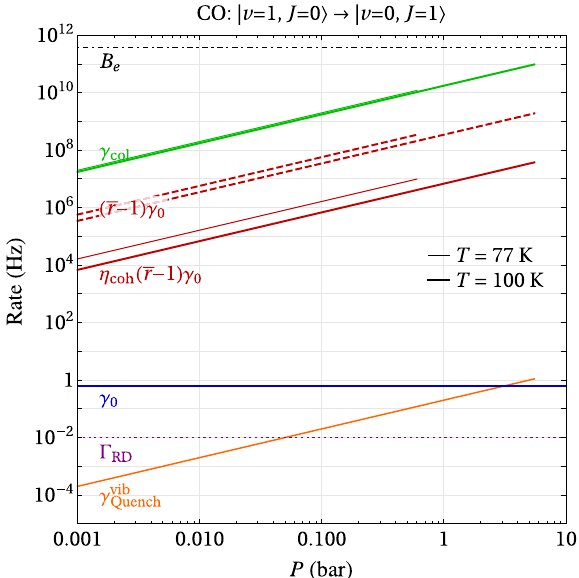
FIG. 7. Rate of absorption Γ (solid green line) and rate of abs FIG. 6. Dynamic rates of the two-level subsystem (solid red line) as a function of focused, coherent emission Γ S rad j v ¼ 0 ; J ¼ 1 i ↔ j v ¼ 1 ; J ¼ 0 i in carbon monoxide (CO), as DM energy ω ≃ m , in the phase I version of the stack configu- a function of pressure P . We plot the collisional broadening rate ration, filled with carbon monoxide (the 12 C 16 O isotopologue) at a γ (green line), the coherent emission rate in the absence or col pressure of 5 bar, temperature of 100 K, and “ stack enhancement presence of decoherence — ð ¯ r − 1 Þ γ 0 as the dashed red lines and ¯ ∼ 10 [cf. Eq. (7)]. The case study shown S=mR parameter ” ¯ r − 1 Þ γ η — for two temperatures T ¼ 100 K z 0 as solid red coh ð assumes a kinetically mixed photon with ϵ ¼ 10 − 12 , zoomed in (thick line) and T ¼ 77 K (thin line). Also shown are the on the energy range around CO ’ s first vibrational absorption line incoherent radiative rate γ 0 (blue line), a benchmark natural j v ¼ 0 i → j v ¼ 1 i at ω e ¼ 0 . 27 eV, with rotational fine struc- radioactive decay rate Γ (dashed purple line) before an active RD ture of splitting 2 B clearly visible. This plot shows that the e veto, and the nonradiative quenching rate γ vib (orange line). thermally occupied rotational levels of the ground state allow us quench The collisional width γ comes within a factor of 3 (30) from the to expand the frequency coverage of vibrational and electronic col rotational energy B (dashed black line) at the boiling point transitions. The dashed green line shows the absorption rate for e pressure of 5.5 bar (0.6 bar) at T ¼ 100 K ( T ¼ 77 K). This 12 C 18 O, displaying the isotope shift on the rovibrational shows that collisional broadening is an effective mechanism for frequency scanning. Notice that because the collisional rate dominates every other dynamical timescale, it reduces the coherent emission rate so that only 1 out of every O ð 1000 Þ DM particles absorbed will produce a photon.